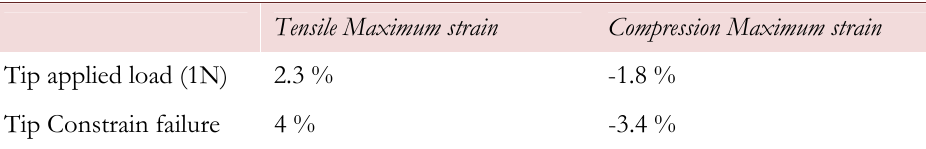
Table 5: Calculated maximum tensile and compressive strains.